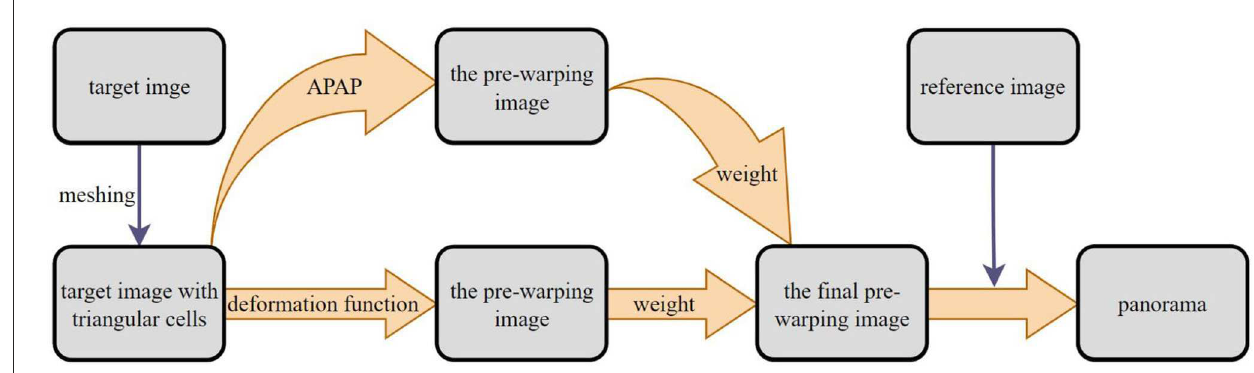
FIGURE1 The schematic diagram of the proposed image stitching method.